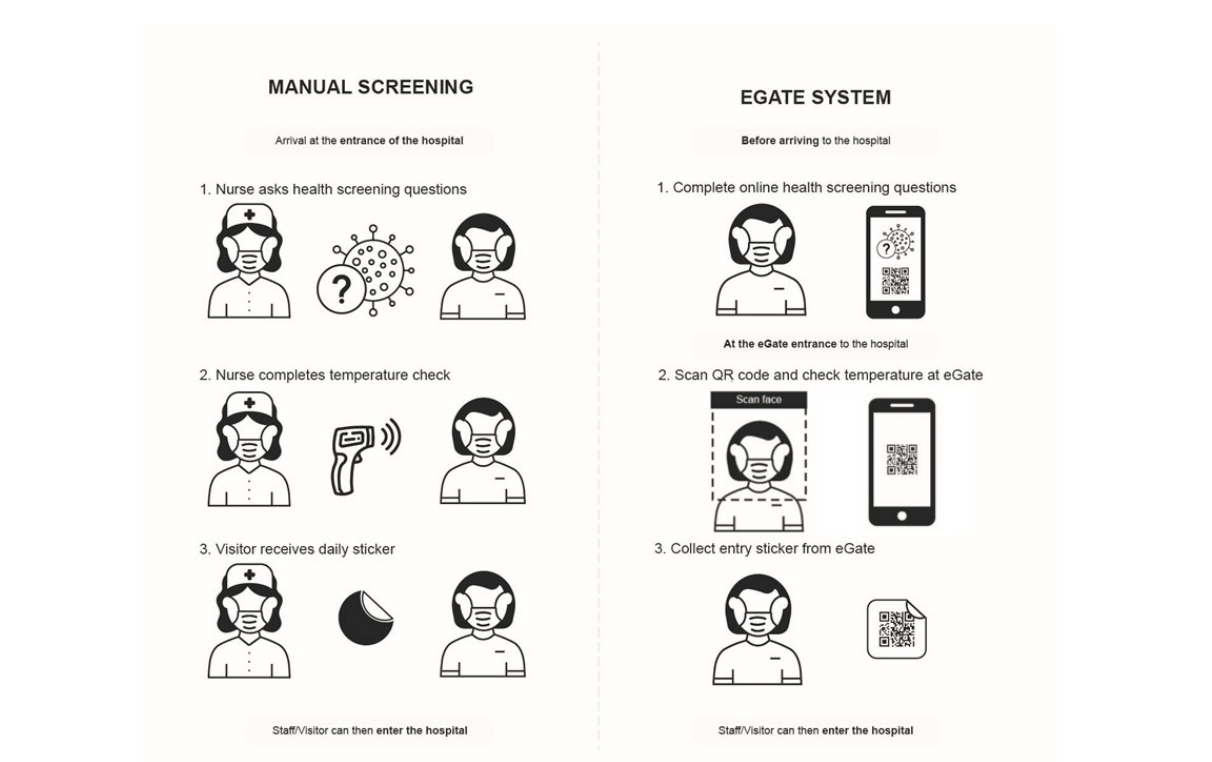
Figure 1. Change in agency from manual to eGate. Left : Manual screening methods; Right : eGate digital screening